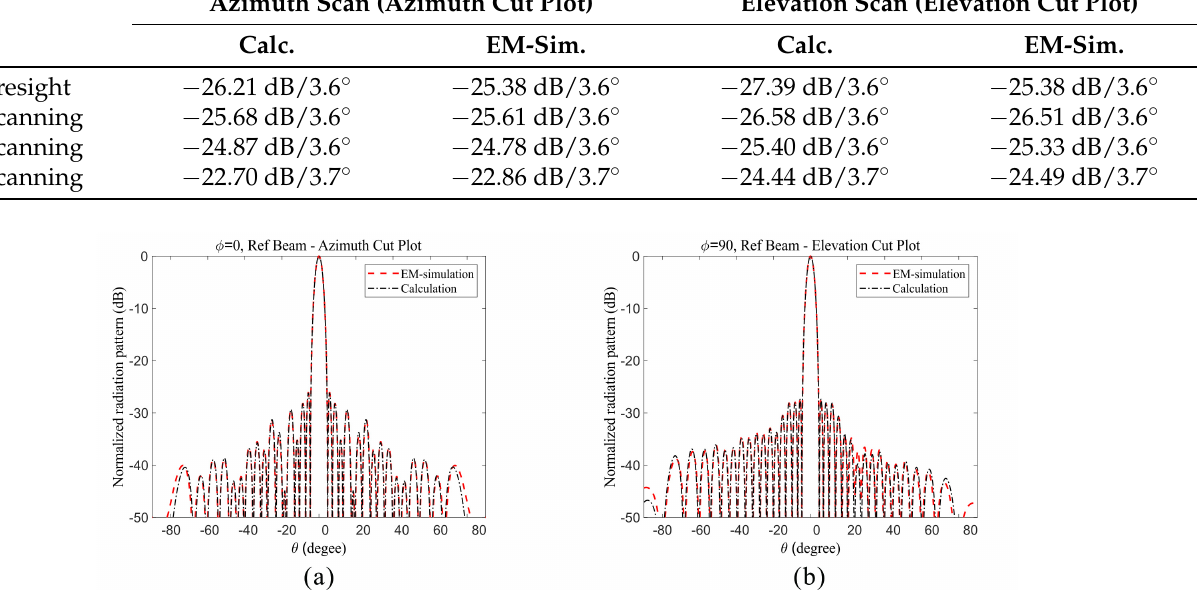
Figure 11. Radiation pattern in the boresight direction at 30 GHz (calculation vs. EM full-wave simulation): ( a ) azimuth cut and ( b ) elevation cut.